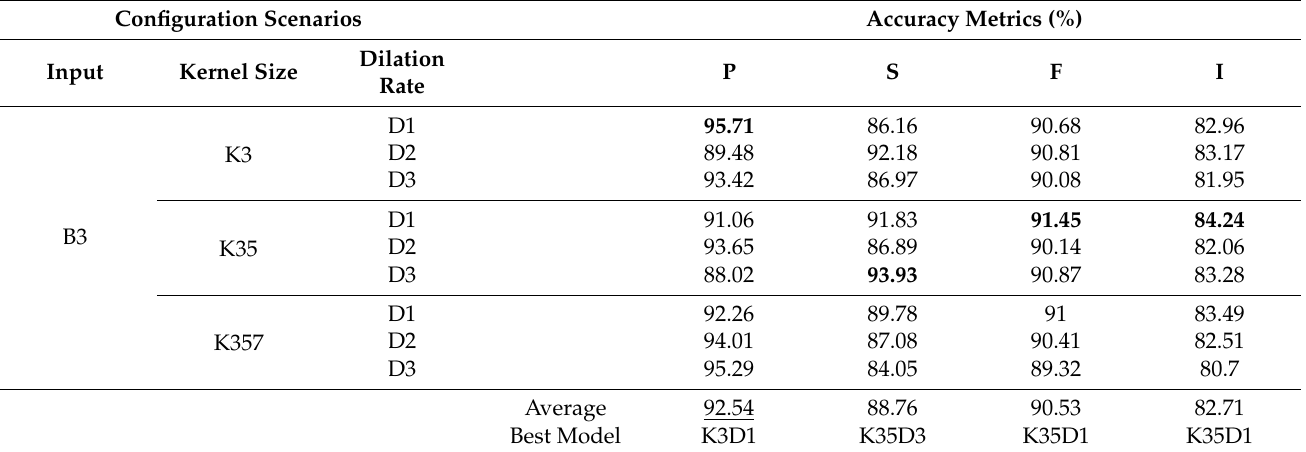
Table 3. Quantitative results of AFD in all scenarios by MultiScale-Net over test samples (P: precision , S: sensitivity , F: F 1- score , and I: IoU ). The highest accuracy metrics of each scenario (B3, B1, and B4) are in bold and the overall best results are